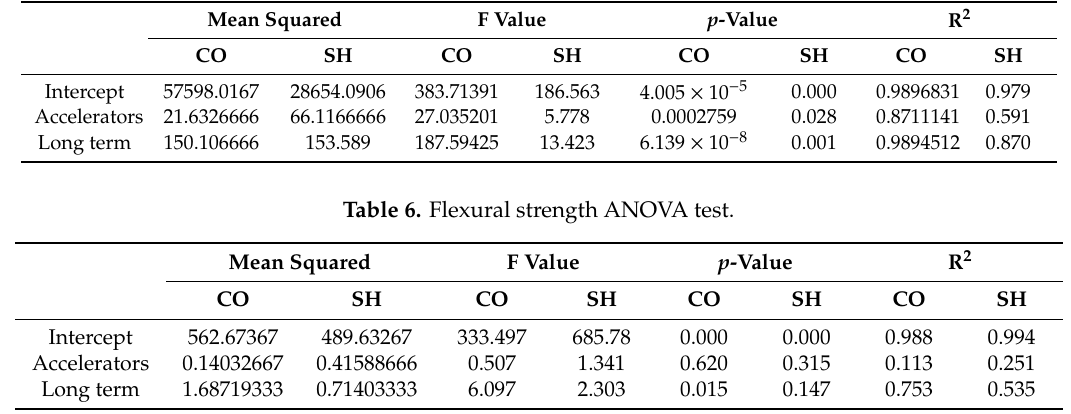
Table 5. Compressive strength analysis of variance (ANOVA) test.